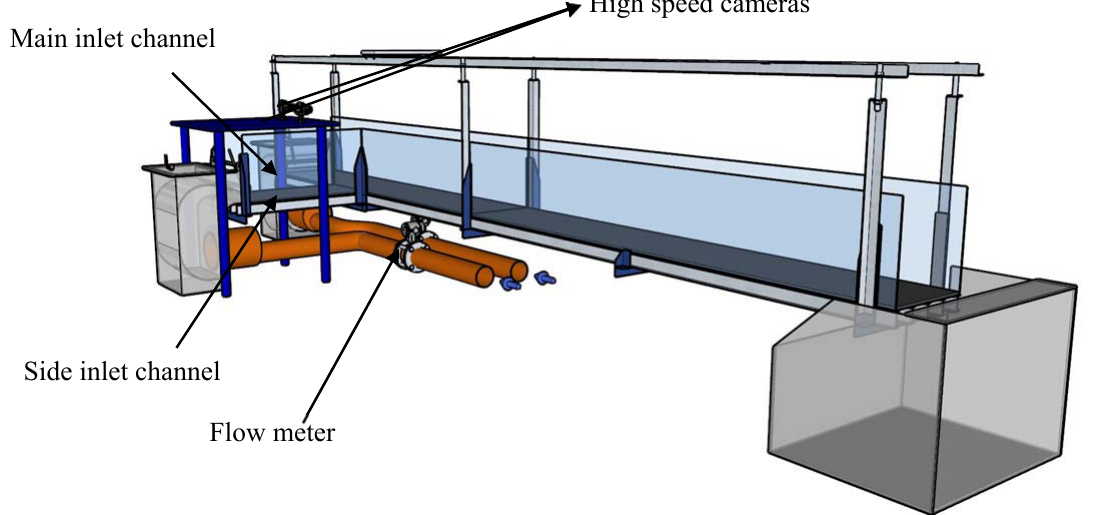
Figure 2. 3D sketch of test